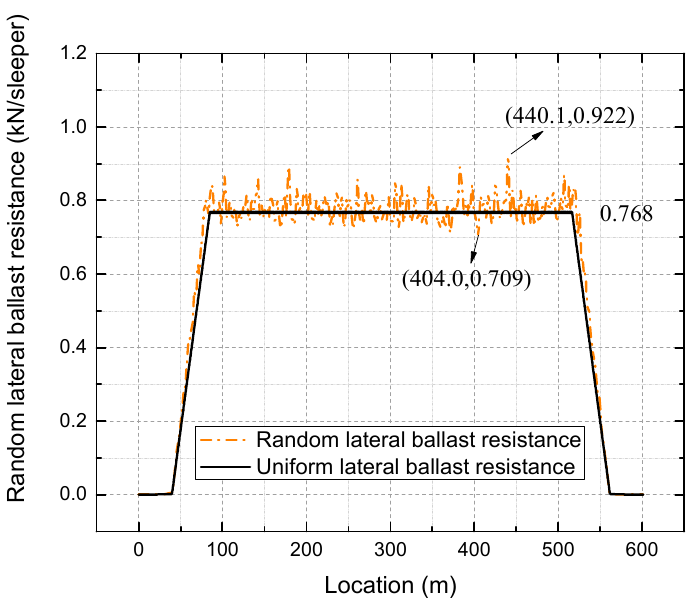
Figure 11. Comparison of lateral track deformation before and after 50 °C temperature increase.